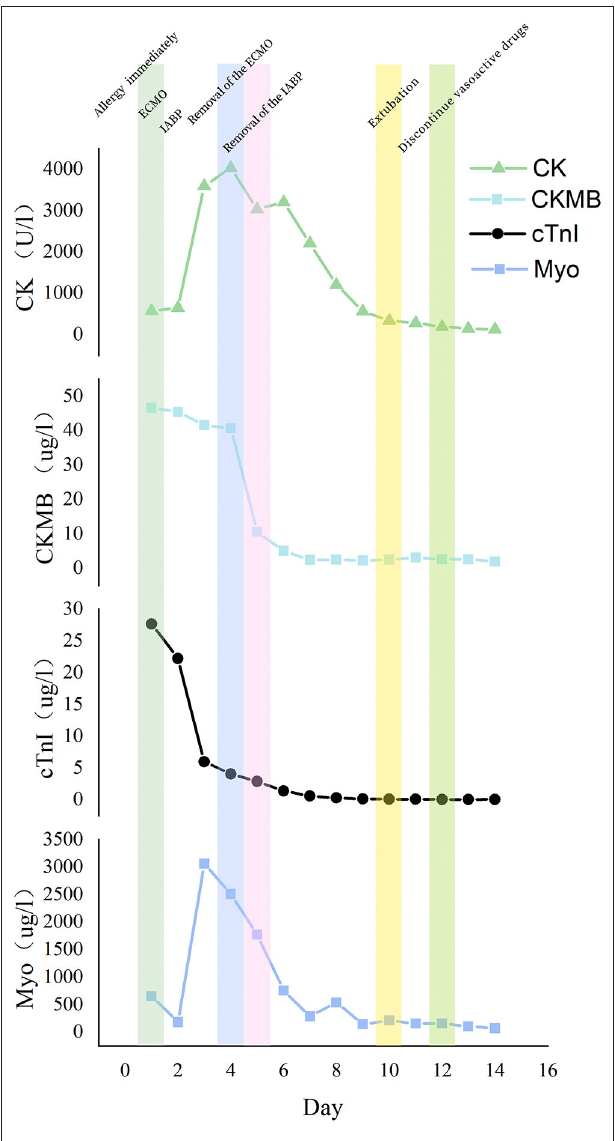
FIGURE 2 | The variation of biomarkers during hospital course. CK, creatine kinase; CKMB, creatine kinase-MB; cTnI, cardiac troponin I; Myo, myoglobin.